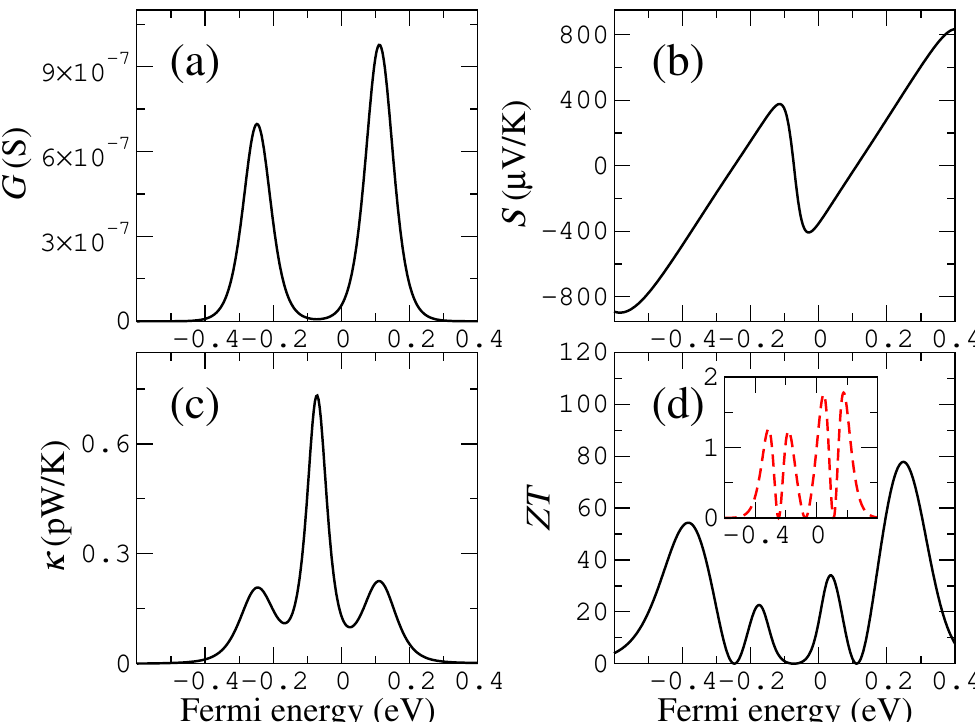
Figure A3. Electrical conductance ( a ), Seebeck coefficient ( b ), thermal conductance ( c ) and figure of merit ( d ) for a graphene wedge facing another wedge. The inset shows the figure of merit calculated with a phonon thermal conductance of 2